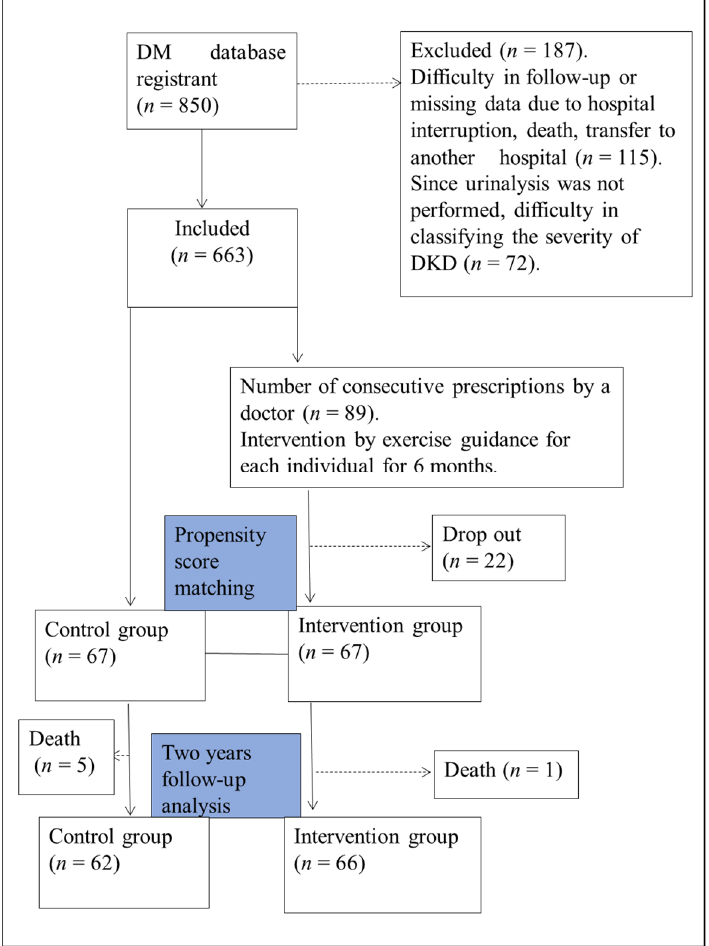
Figure 1. Study flowchart. This is a single-center, prospective intervention study using propensity score matching. The study population comprised 663 patients who could be followed up. Sixty-seven patients who completed the 6-month intervention were designated as the Intervention group. The 67 patients in the cohort group matched by propensity score matching with the intervention group were designated as the control group and followed up for 24